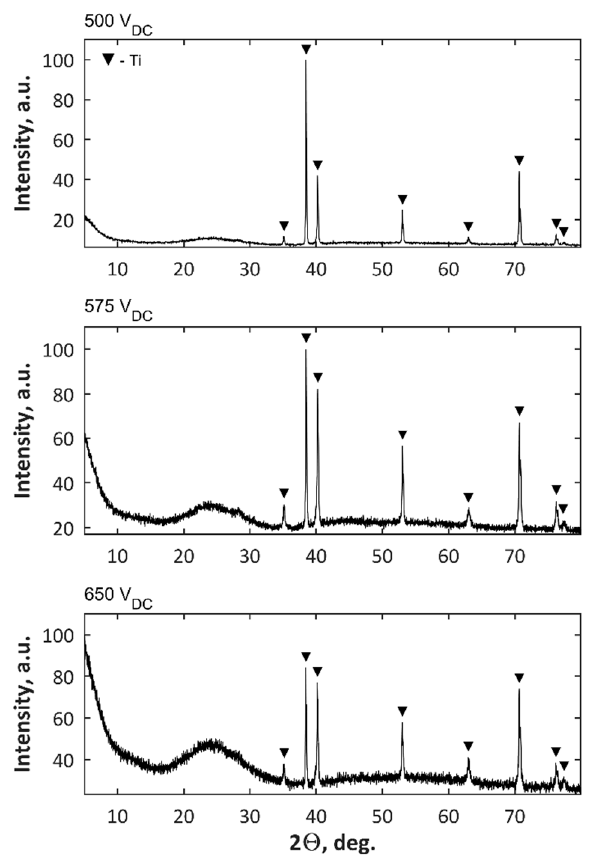
Figure 13. XRD results of coatings after PEO processing obtained in electrolytes composed of Mg(NO 3 ) 2 ·6H 2 O and Zn(NO 3 ) 2 ·6H 2 O in H 3 PO 4 at a concentration of 500 g/L at three voltages 500 V, 575 V, and 650 V.